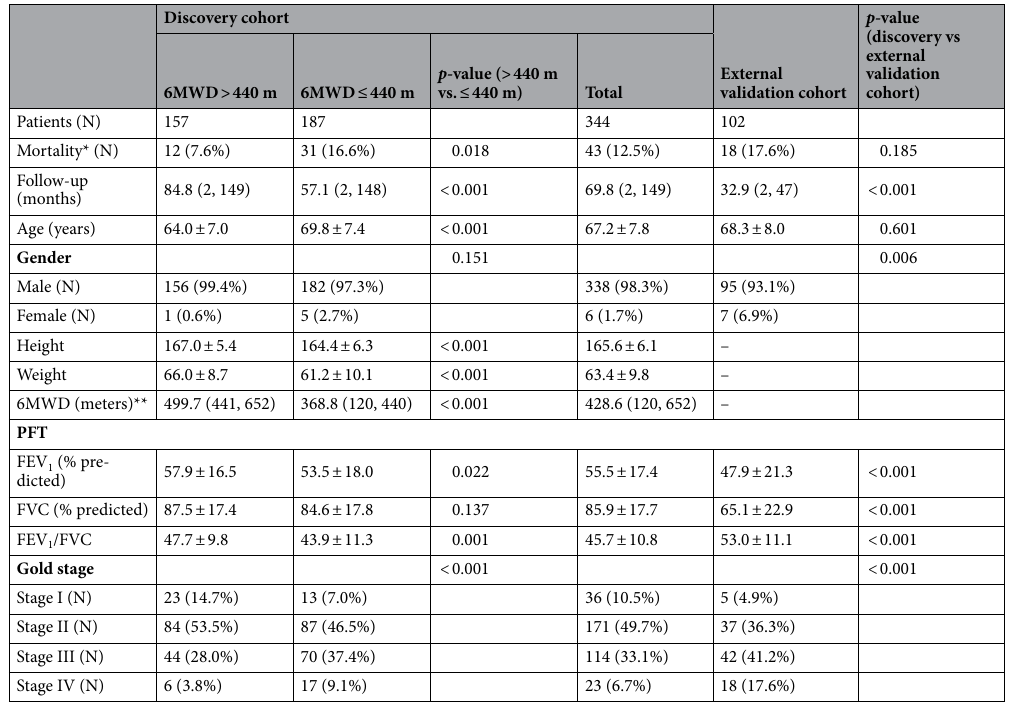
Table 1. Baseline clinical characteristics and mortality data. Continuous variables are presented as mean ± standard deviation and categorical data are presented as the number of patients with percentages in parentheses. ‘Follow-up’ and ‘6MWD’ are presented as the mean with minimum and maximum values in parentheses. 6MWD six-minute walk distance, PFT pulmonary function test, FEV 1 forced expiratory volume in 1 s, FVC forced vital capacity, GOLD Global Initiative for Chronic Obstructive Lung Disease. *Overall survival was investigated as study end-point, which is defined as the time until death from any cause. **6MWD information was only in the discovery cohort, and Supplementary Figure S2 shows the distribution of